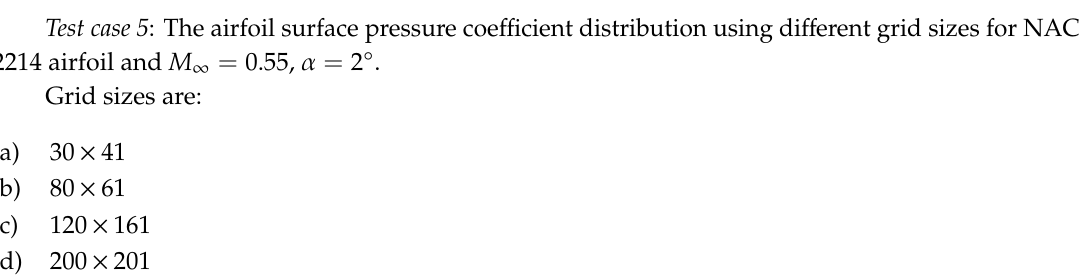
Figure 17. The pressure coefficient distribution. Comparison of FOILcom result and the one from ANSYS Fluent (V19.2).